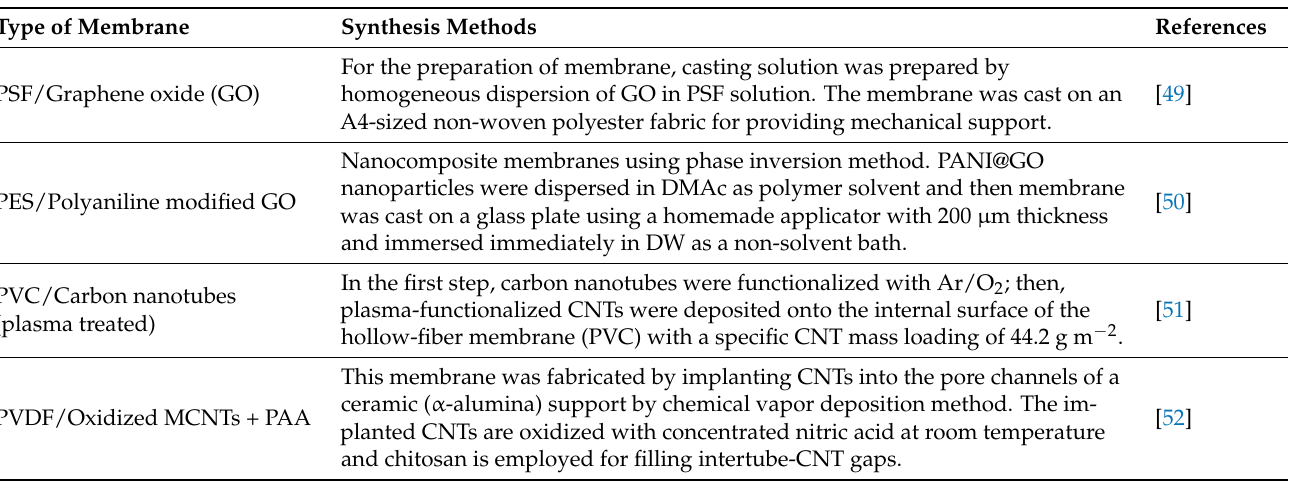
Figure 3. ( A ) Graphic of two types of 2DNMs membrane: porous nanosheet membranes and laminar membranes (re- produced from [41] with permission from the American Chemical Society). ( B ) Fabrication of 2DNM membranes: ( a ) A schematic illustration of freestanding rGO membranes fabricated by vacuum-assisted method (reproduced from [44] with permission from the Wiley Online). ( b ) Synthesis of free-standing MXene/ANF (reproduced from [45] with permission from the nature) and ( c ) MXene/polymer membrane by vacuum-assisted filtration methods (reproduced from [46] with permission from the PNAS). ( d ) Schematic illustration of the formation of an NLGM via the sol-gel process (reproduced from [48] with permission from the royal society of chemistry) [44]. Table 1. Synthesis procedure of different 2DNM